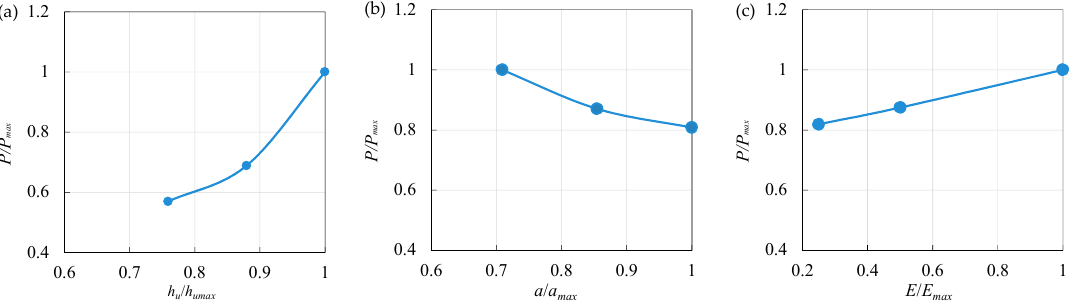
Figure 14. Variation of wave pressure on the structure with different parameters: ( a ) the height of the water column; ( b ) the distance between the water column and the structure; and ( c ) the Young’s modulus.